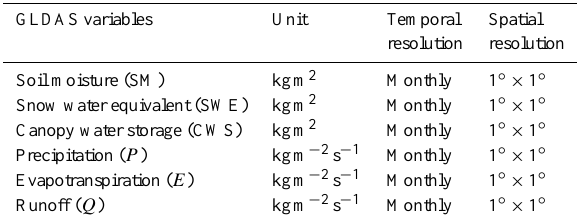
Table 2. Variables used from the GLDAS simulations. GLDAS variables Unit Temporal Spatial resolution